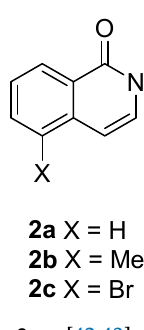
Figure 2. Reduction of nitroheterocyclic isoquinolinones 3a–c [42,43].